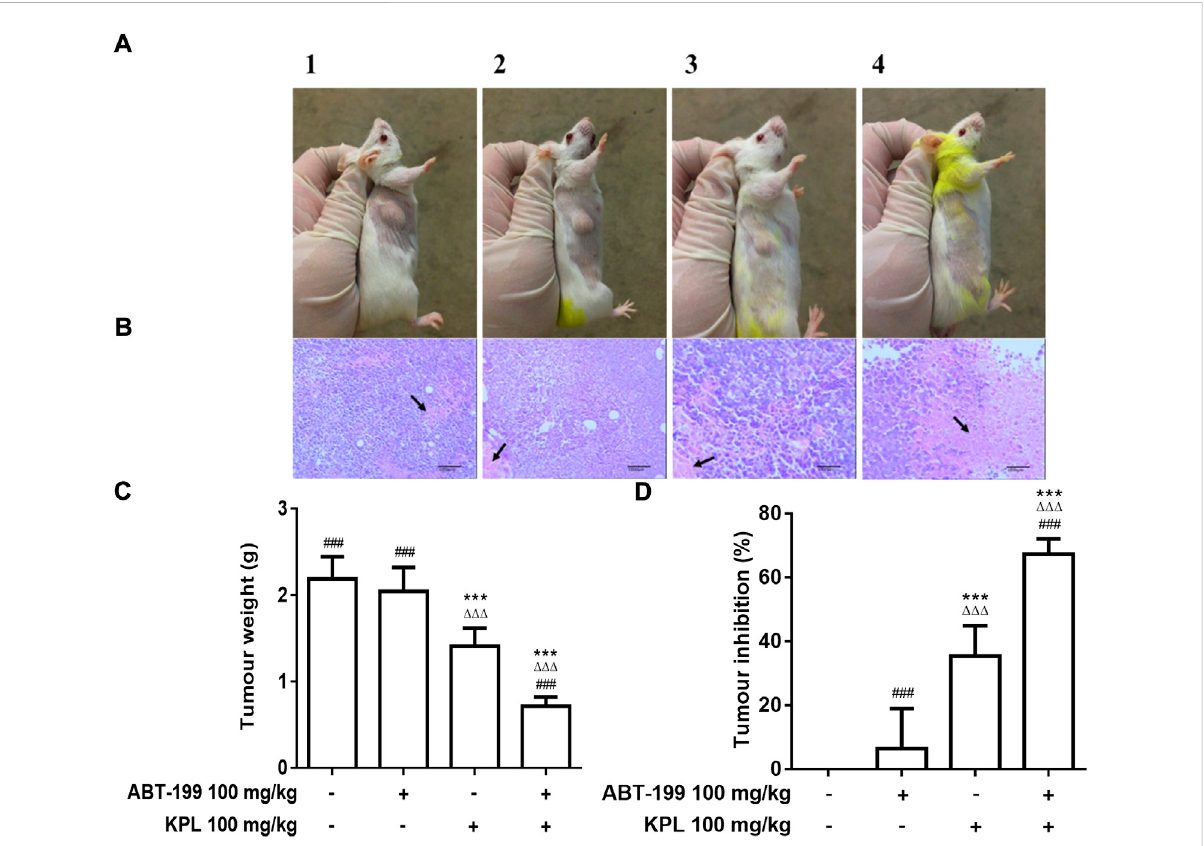
The effect of KPL combined ABT-199 on tumour growth and tumour cells necrosis in H22 tumour-bearing mice. (A) Representative images of thetumorsinvariousgroups.Thesizeoftumorsineachgroupcanbeseenwiththenakedeye:comparedwiththecontrolgroup, thetumoursizeof KPL only group and KPL combined with ABT-199 group were signi fi cantly reduced, whereas the KPL combined with ABT-199 group were more signi fi cantly reduced. A1: Control group, A2: ABT-199 100 mg/kg group, A3: KPL 100 mg/kg group, A4: KPL 100 mg/kg + ABT-199 100 mg/kg group. (B) Histological examination of tumour tissues from H22 tumor-bearing mice. The tumorus were sectioned and stained with H&E. The necrotic tumor foci were indicated by the black arrows. B1: Control group, B2: ABT-199 100 mg/kg group, B3: KPL 100 mg/kg group, B4: KPL 100 mg/kg+ABT-199100 mg/kggroup. (C) Tumorweightsofthemiceineachgroupattheendoftheexperiment. (D) Tumorinhibitionpercentage ofthevarioustreatments.Magni fi cation:100×.Valuesaremeans±SD( n =10).*** p < 0.001 versus negativecontrolgroup; ΔΔΔ p < 0.001 versus ABT- 199 alone group; ### p < 0.001 versus KPL alone